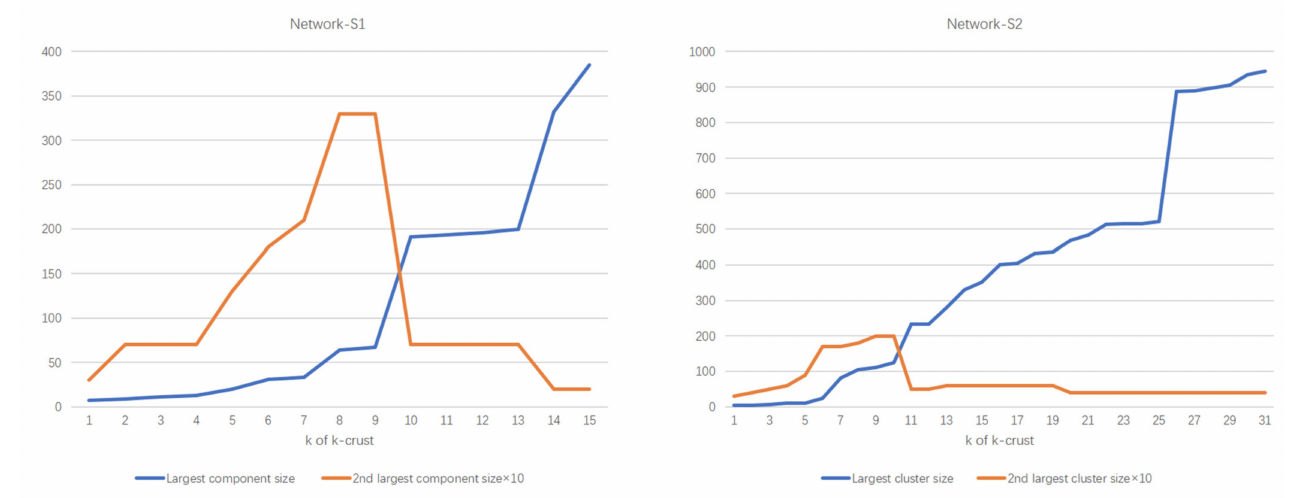
Figure 2. Size of the largest vs. second-largest component in